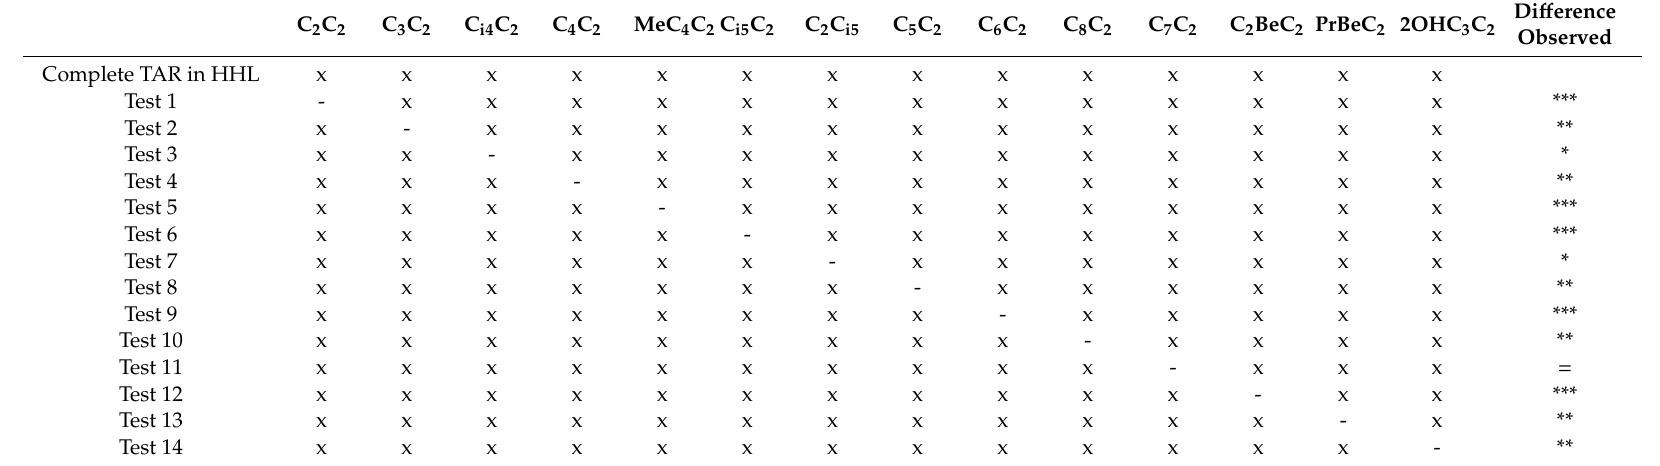
Table 4. Olfactory impact of the omission of various esters from complex aromatic